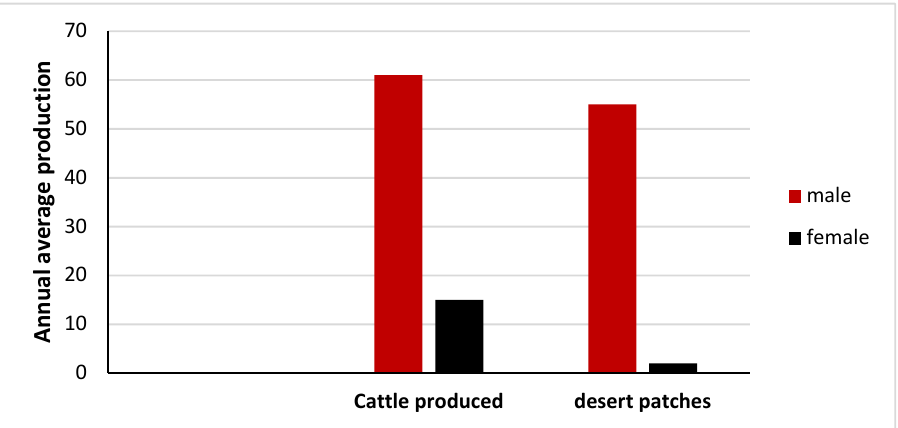
Figure 9. Average number of cattle produced and desert patches created by male- and female-headed households (n female games = 22; n male games = 22).